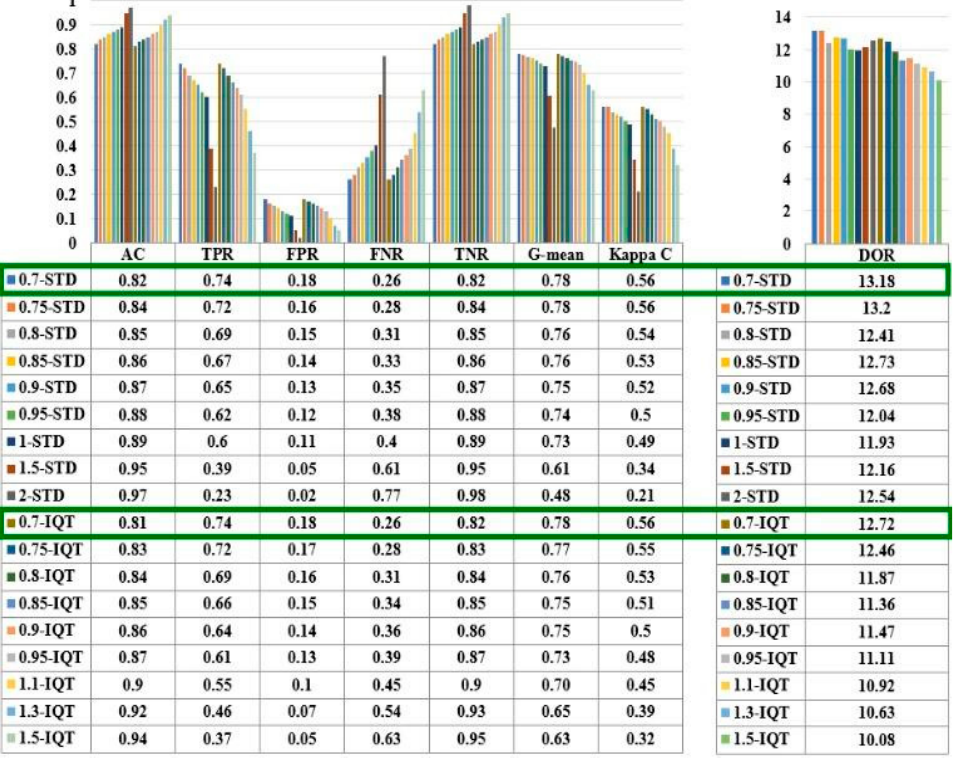
Figure 5. Confusion matrix parameters, ACC and DOR FoM for ABI/GOES LST anomalies for the STD and IQT methods, and all ‘C’ values.